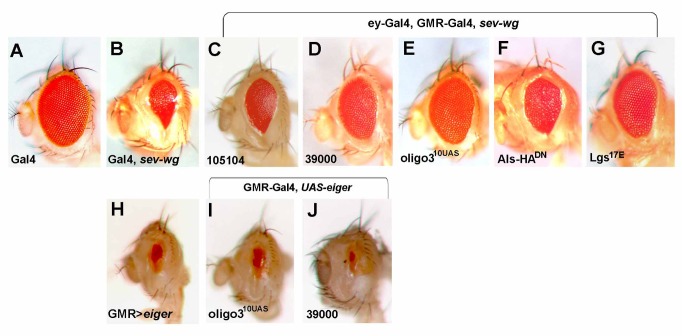

als acts downstream of Wg.Control eye with ey-Gal4, GMR-Gal4/+ (A). The small eye phenotype based on sev-wg expression (B) can be suppressed by the expression of different UAS-alsRNAi transgenes (C–E), by expression of UAS-alsHA(DN) (F), and by overexpression of Lgs17E, which suppresses Wg signaling (G). The small eye phenotype based on enhanced apoptosis (H) is not altered upon als depletion (I and J).